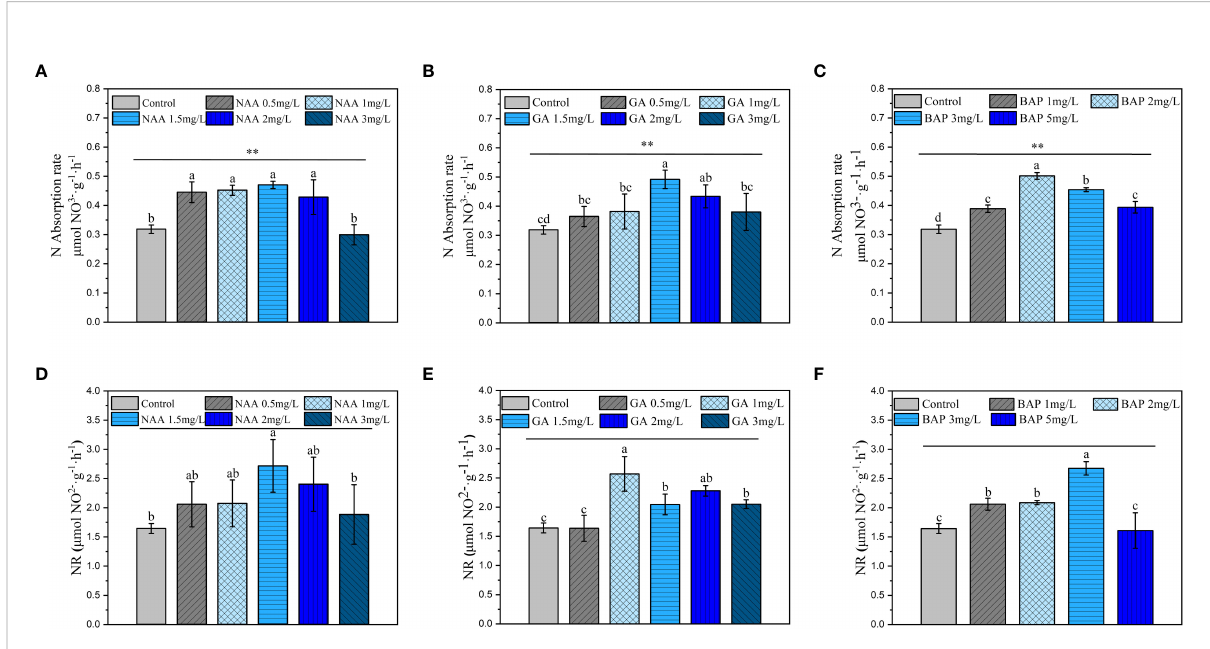
FIGURE 5 Effects of three exogenous hormones on the uptake and reduction of nitrate nitrogen by Sargassum fusiforme holdfasts. (A – C) : uptake rate of nitrate nitrogen by holdfasts under different culture conditions; (D – F) : nitrate reductase activity in holdfasts under different culture conditions. Values are the mean ± standard deviation (n = 3). Different letters indicate signi fi cant differences between different culture conditions (p < 0.05). **indicates intergroup variability between different concentrations of exogenous hormones (**p <